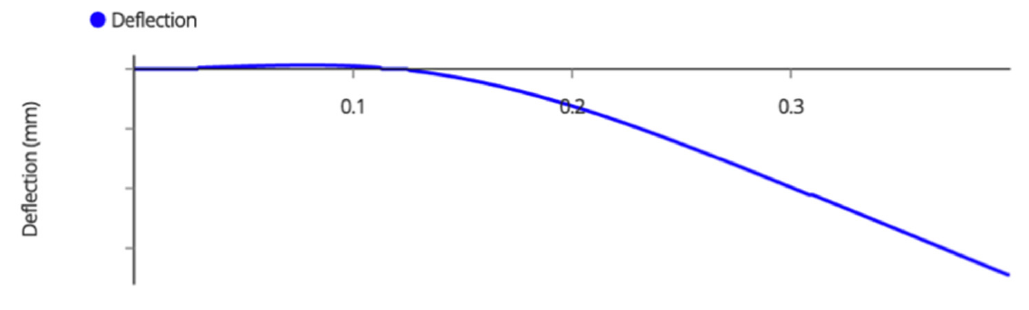
Figure A11. Post-Bending Moment Diagram.